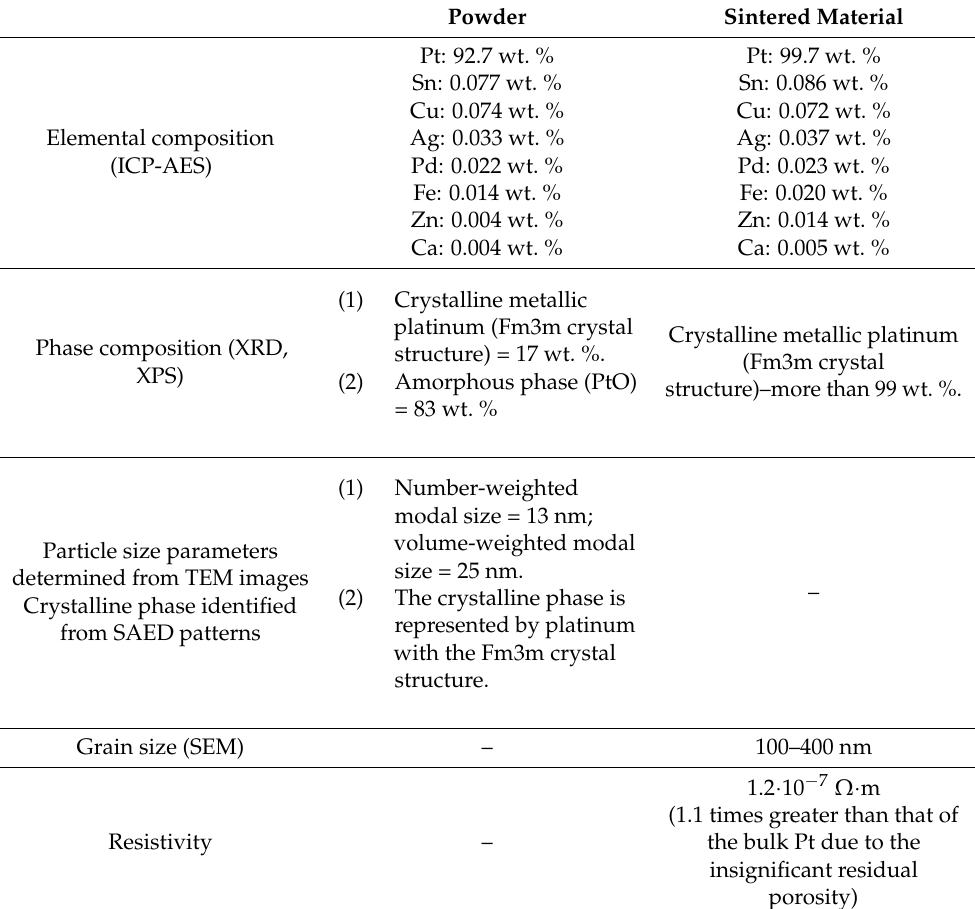
Table A1. Results of the characterization of the powder produced by spark discharge and the sintered